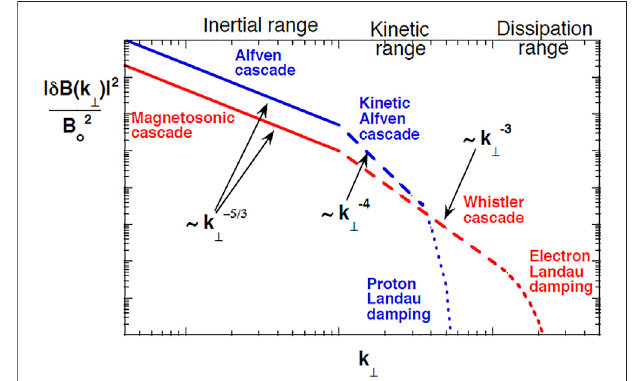
FIGURE 1 | Schematic energy spectra suggesting the co-existence and competition between kinetic Alfvén turbulence (Alfvén channel) and whistler turbulence (magnetosonic channel) in the short-wavelength range. Each type of turbulence may have a non-trivial domain over which it dominates the magnetic fl uctuation spectra. Picture drawn by Peter